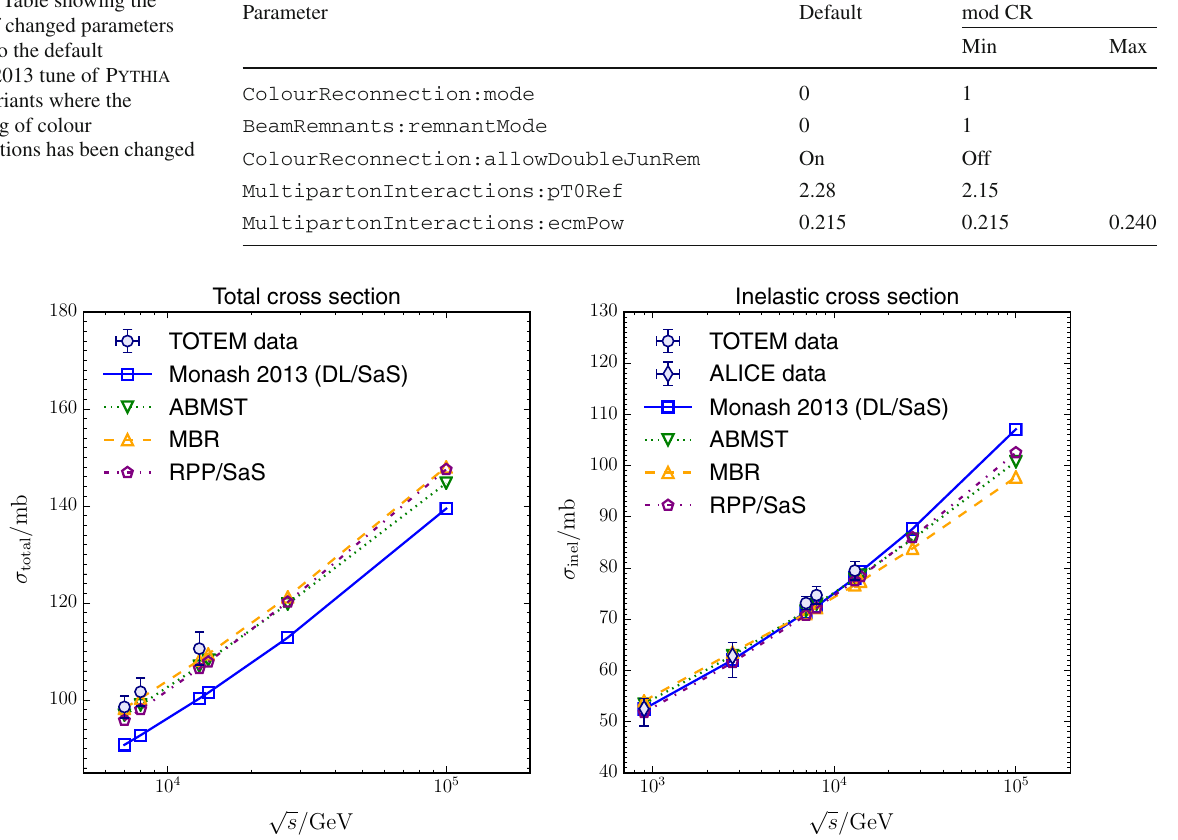
Table 3 Table showing the values of changed parameters relative to the default Monash2013 tune of Pythia 8.2 in variants where the modelling of colour